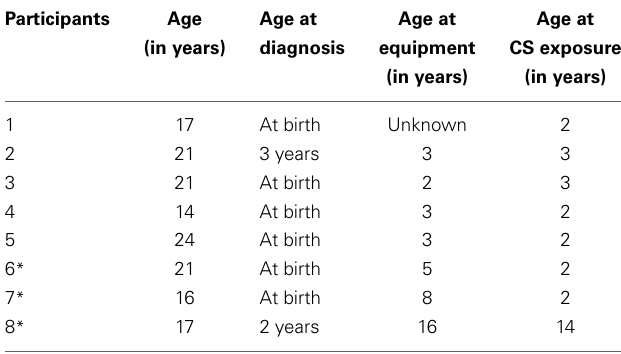
Table 1 | CS-deaf group